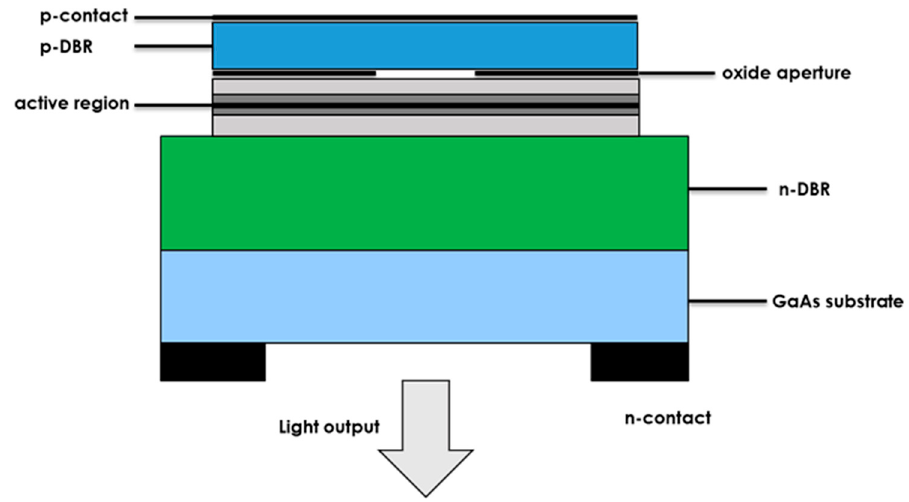
Figure 1. Schematic diagram of the high heat flux bottom emitting VCSEL structure. Table 1. Heat dissipation requirements of VCSEL arrays. Table 1. Heat dissipation requirements of VCSEL